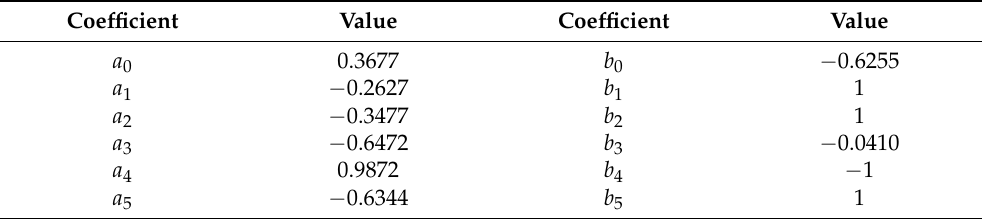
Table 6. Coefficients obtained for a 5th order polynomial model by means of the Jaya algorithm using the 80-point